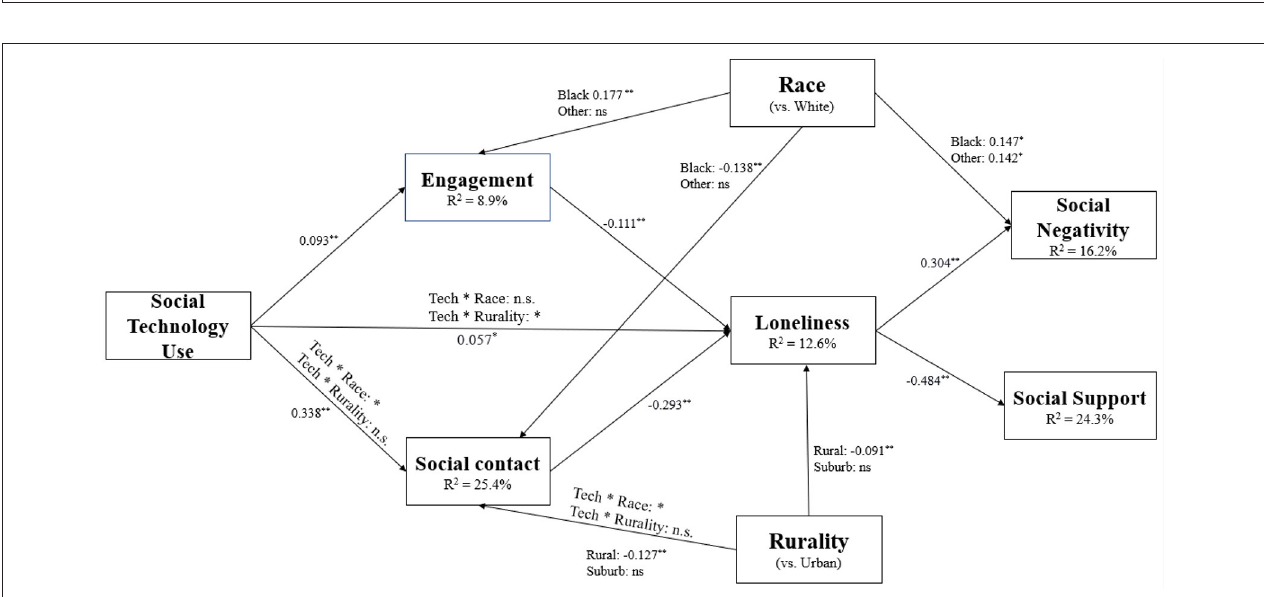
FIGURE 1 | Conceptual model of the relationship between social technology use and loneliness. Race (White/Caucasian, Black/African American, and members of other racial/ethnic backgrounds) and rurality (rural suburban, and urban) were examined as moderators. Social engagement and social contacts were included as mediators of this putative relationship. Age, marital living arrangements (live with spouse/partner vs. not), and frequency of general computer usage were included as covariates in the model.